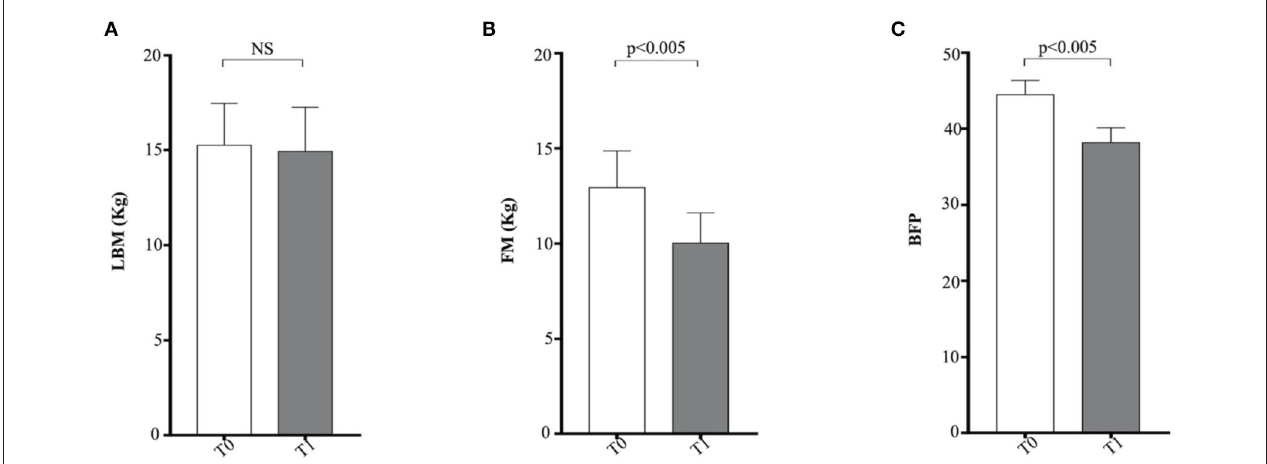
FIGURE 1 | Morphometric equations in enrolled dogs. (A) LBM, lean body mass; (B) FM, fat mass; (C) BFP, body fat percentage. Obese dogs at T0, white column; obese dogs at T1, gray column. Statistics: Wilcoxon matched-pairs signed-rank test was used for T0 and T1 comparation in obese dogs. NS means not significant difference.